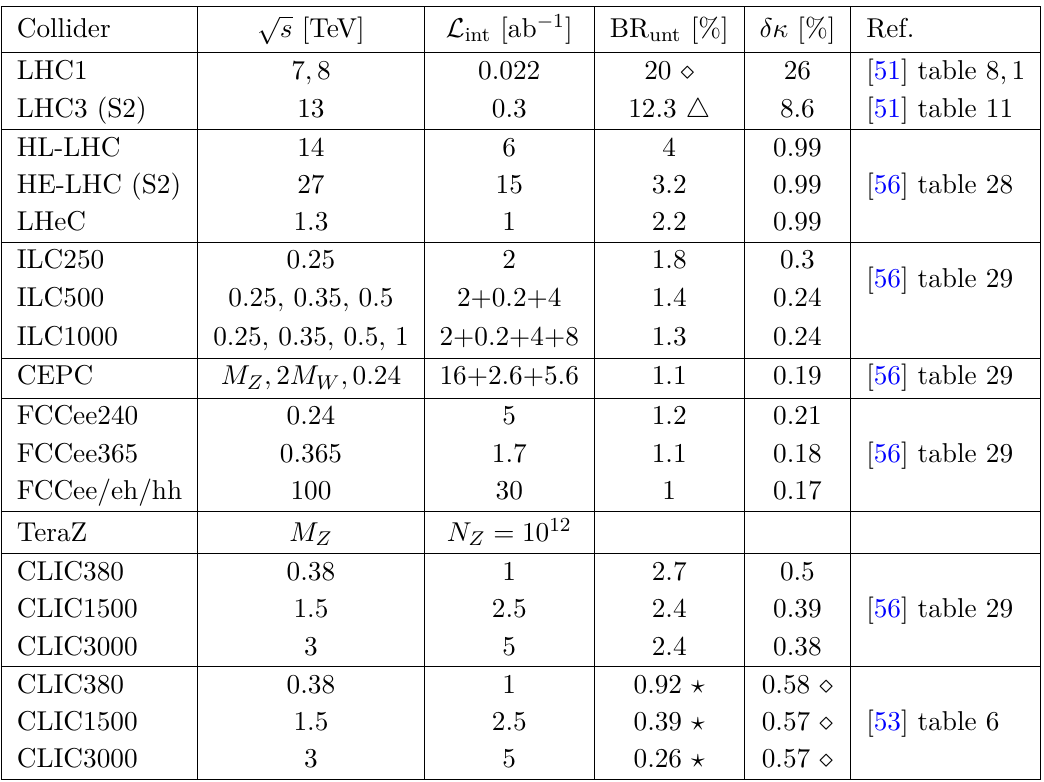
Table 1 . Upper bounds on BR ( h → unt ) at 95% CL from global fits of Higgs signal strengths for different colliders. (cid:5) : 2-parameter fit of κ and BR 1-parameter fit of BR (applicable to low sin θ because κ ≡ 1 ); if not labeled, then multi- κ fit BSM of BR . BR can be interpreted as a conservative BR unt BSM approximately 95% CL was obtained by multiplying the 68% CL bound by 1.3, the ratio of the quantiles of a χ 2 distribution with 7 parameters. δκ denotes the 68% CL uncertainty of the modifier of the most precisely determined Higgs coupling, i.e. δκ where δκ is W